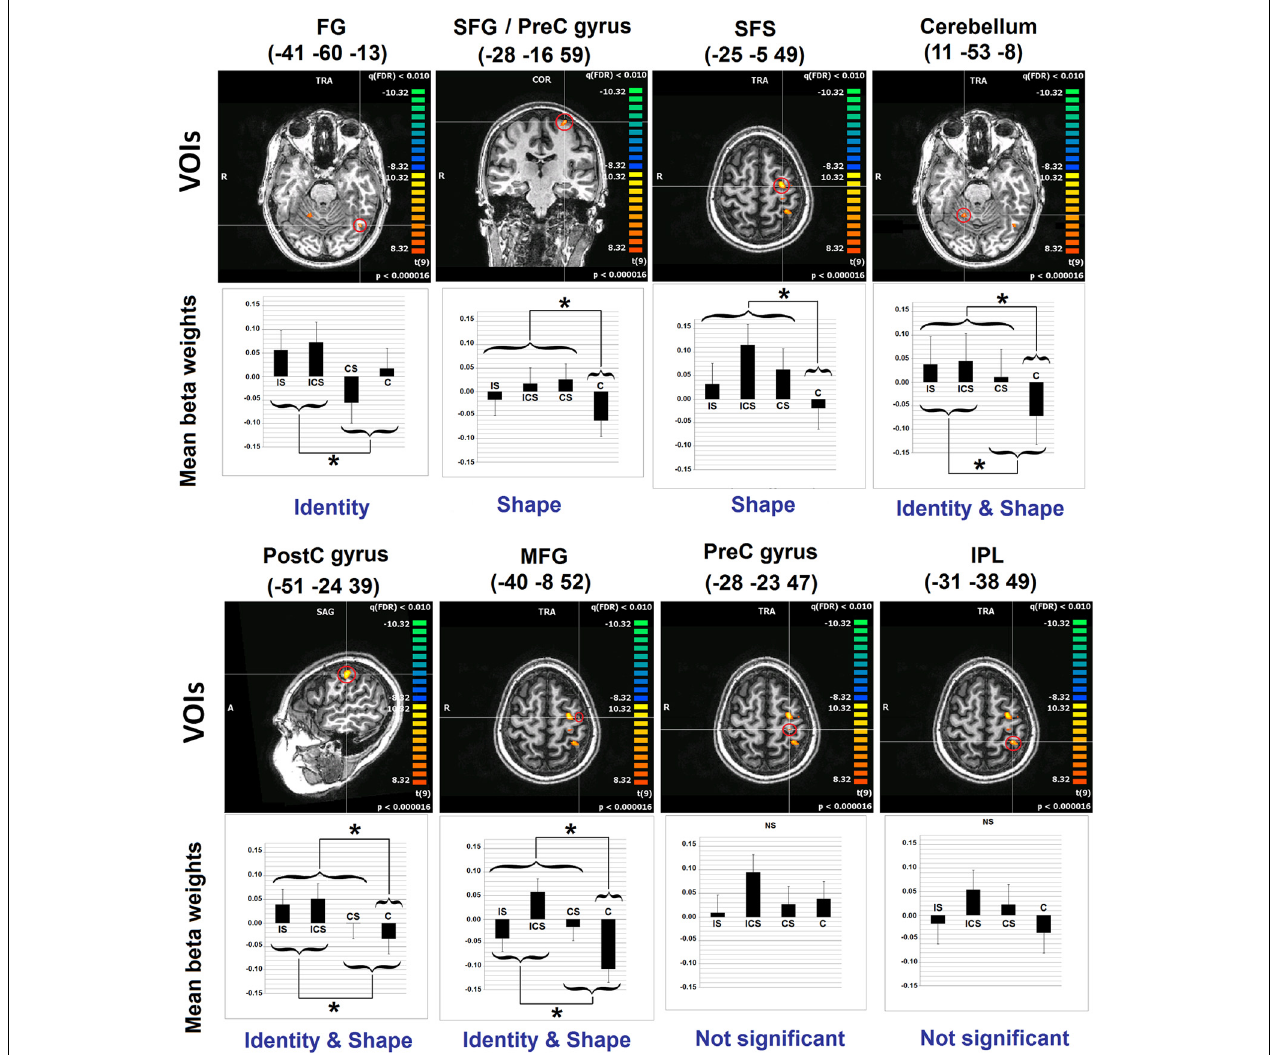
FIGURE 2 | Results of Analyses 1 and 2. The 8 clusters identified in Analysis 1 are depicted. With regard to Analysis 2, bar graphs represent the mean beta values (and SEs) across voxels in each of the depicted VOIs, for each of the experimental conditions. Indicated also are the results of the linear contrasts performed at each VOI, with brackets indicating the grouping of conditions that